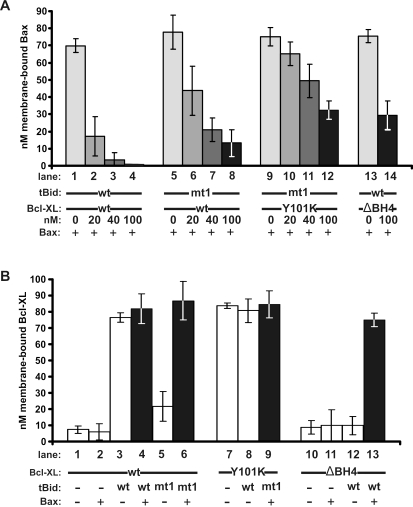
Bcl-XL Binding to Membranes and Bcl-XL-Mediated Inhibition of Bax Membrane Binding Are Mediated by Interactions with tBid and Bax(A) Quantification of Bax binding to membranes. Bax (100 nM) and tBid (20 nM) or tBid-mt1 were incubated with liposomes in the presence of increasing concentrations of Bcl-XL, Bcl-XL Y101K, or Bcl-XL ΔBH4. Membrane-bound protein was separated from soluble protein by Sepharose CL-2B gel filtration chromatography and quantified by immunoblotting. Results are presented as mean ± standard deviation for at least three independent experiments.(B) Quantification of Bcl-XL and Bcl-XL mutant protein binding to membranes. Bcl-XL, Bcl-XL Y101K, or Bcl-XL ΔBH4 (100 nM) was incubated with the indicated proteins and analyzed as above. Results are presented as mean ± standard deviation for at least three independent experiments. Black bars indicate experiments directly comparable between (A) and (B).